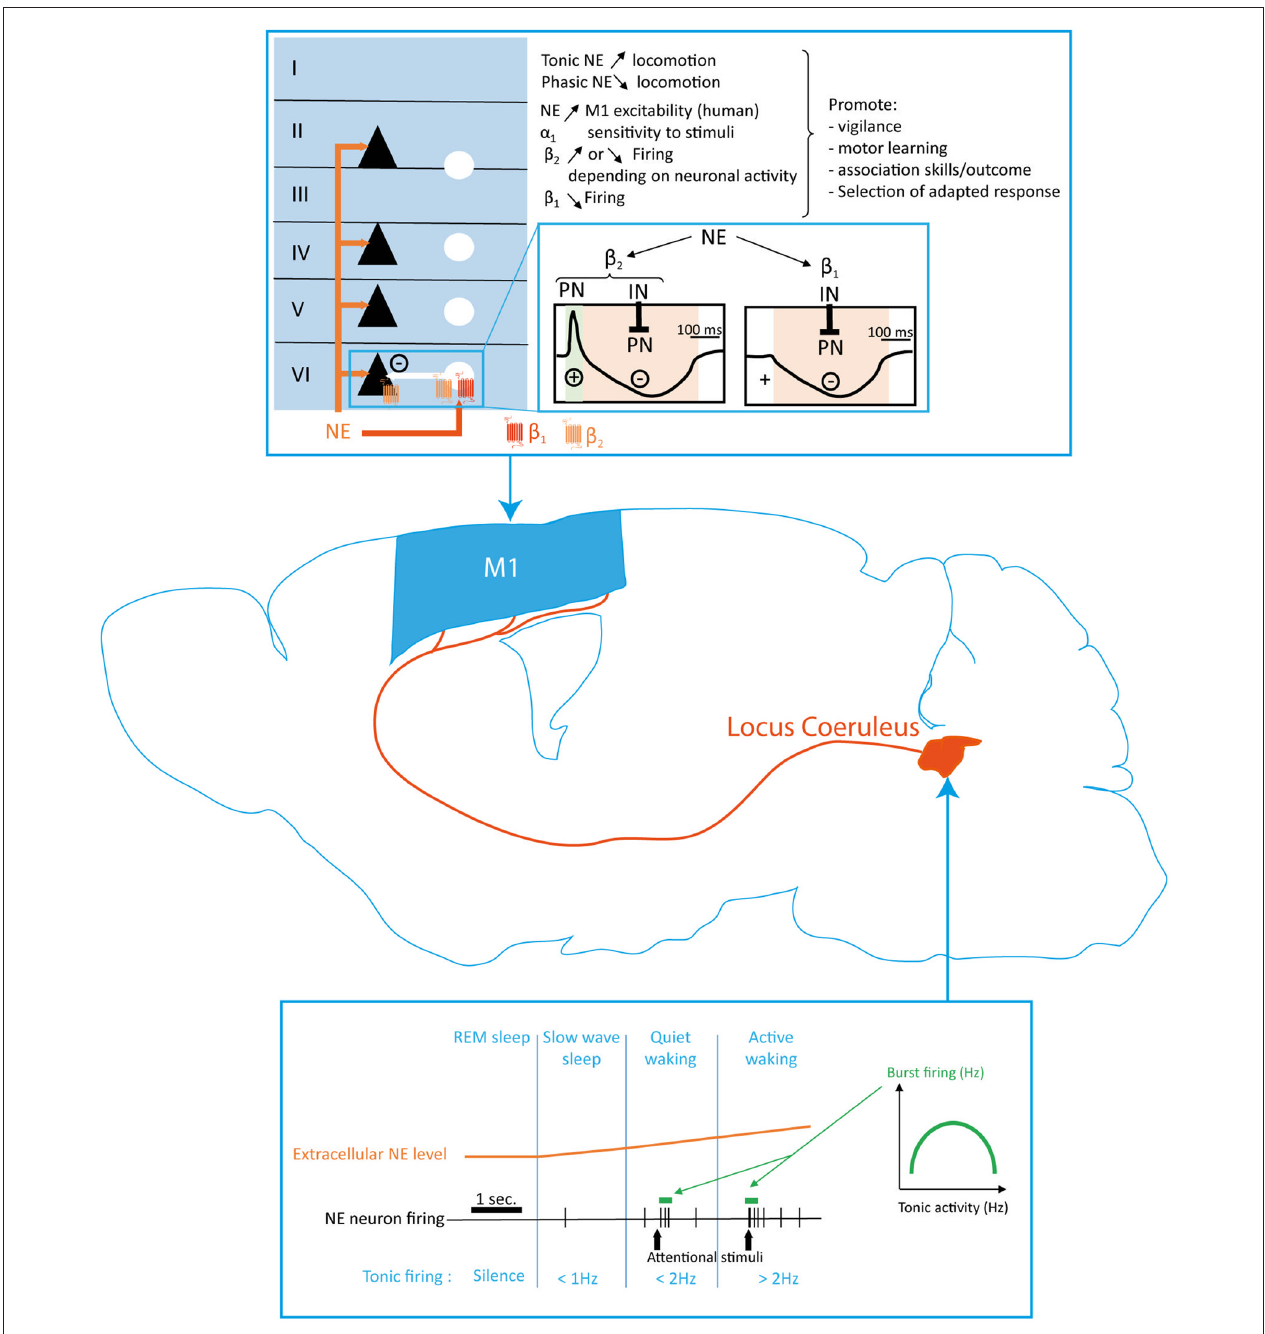
FIGURE 3 | Norepinephrine (NE) modulation of the motor cortex function. NE innervation in M1 originates in the Locus Coeruleus (LC) and terminates homogeneously in all cortical layers. Extracellular NE levels are determined by different neuronal firing frequencies related to the wake/sleep state and firing patterns in response to external stimuli. Tonic and phasic NE release respectively promotes and reduces locomotion. NE exerts its effects in M1 through α 1 , β 1 and β 2 receptors located on projection neurons (black triangles) and interneurons (white circles). The differential expression of β 1 and β 2 receptors by both neuronal populations (blue inlay) results in two different sequence of excitation/inhibition response in M1 projection neurons. NE modulation of M1 plays a key role in modulating motor response in accordance to the level of vigilance and attention required by the behavioral situation. NE, norepinephrine; PN, pyramidal neuron; IN, interneuron.